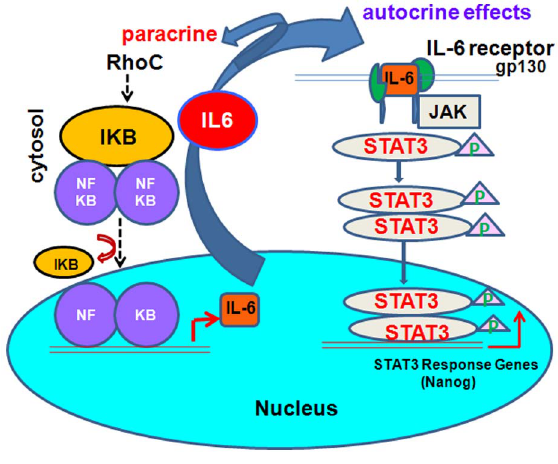
Figure 7. A sketch diagram showing the probable steps involved in nanog activation by RhoC, mediated through the IL-6 and JAK/STAT3 pathway in head and neck cancer